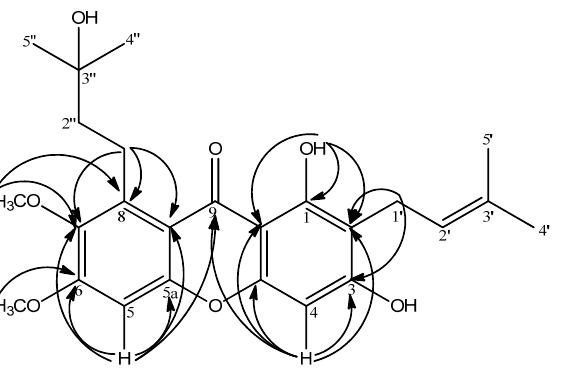
Figure 3. Key HMBC correlations between 1 H and 13 C in compound 1